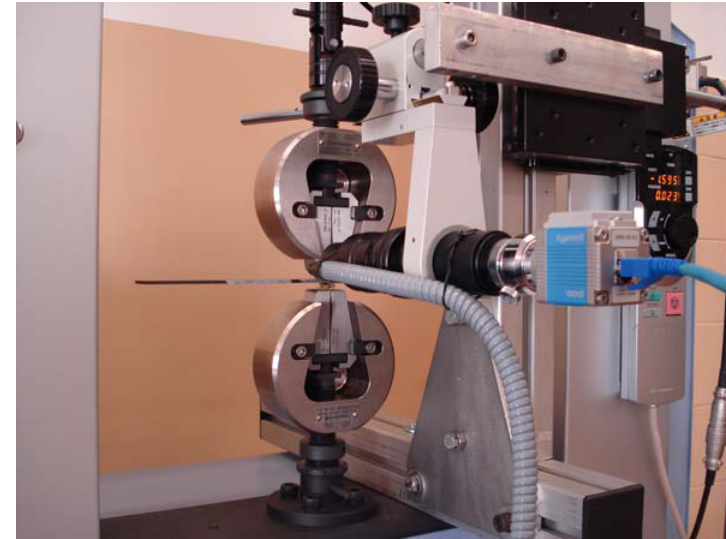
Figure 3: DBC test apparatus with CCD camera video